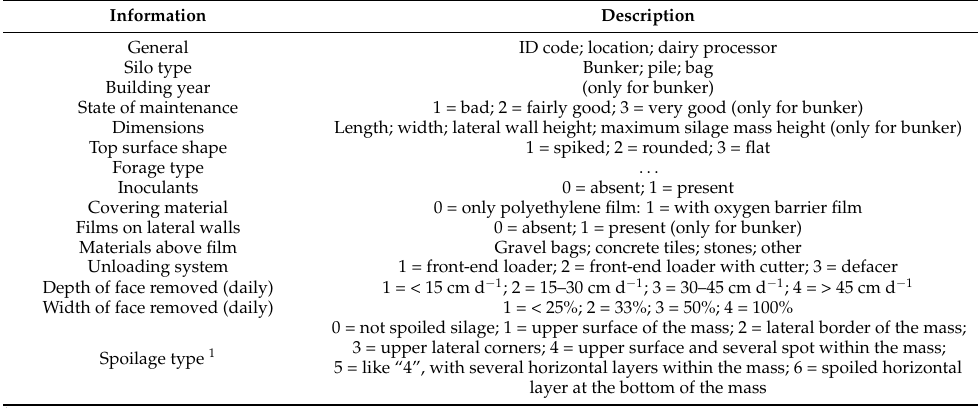
Table 1. Main points of the questionnaire adopted in the survey on silo features and management in the 108 dairy farms in